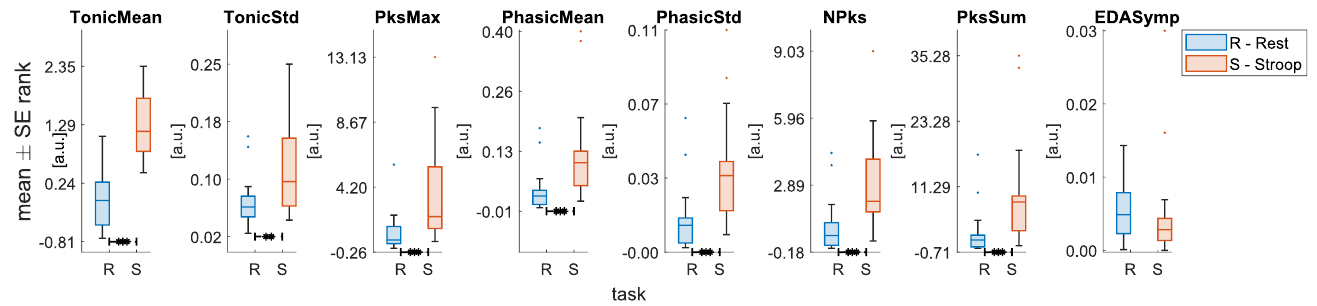
Figure 5. Statistical comparison for each of the EDA features extracted. Significant differences between Rest and Stroop sessions after the Wilcoxon signed rank test with FDR-BH correction are highlighted with an asterisk (* = p < 0.05; ** = p < 0.01; *** = p < 0.001).